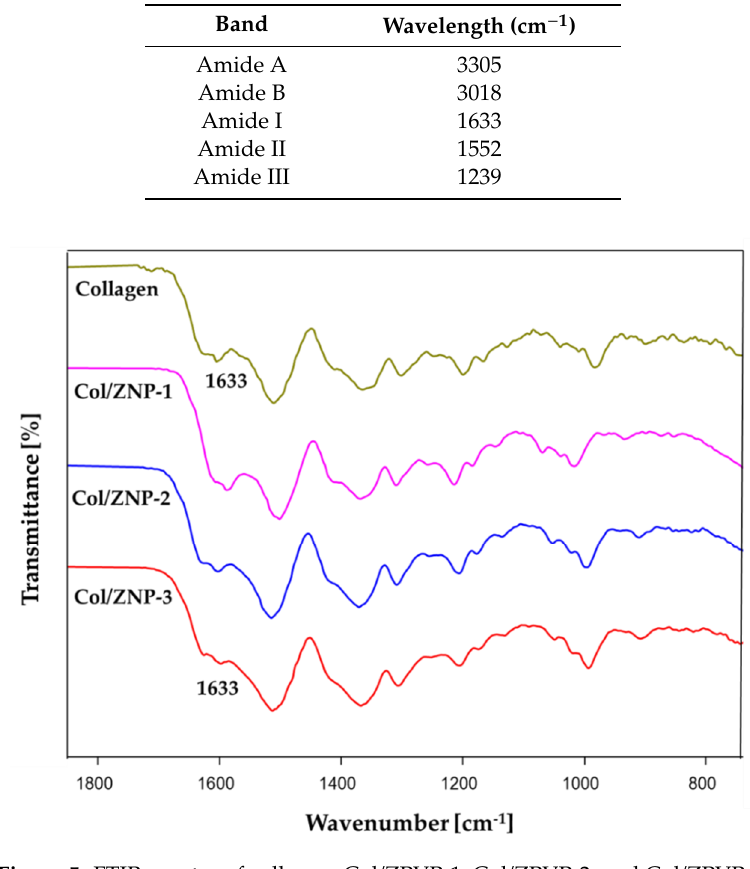
Figure 5. FTIR spectra of collagen, Col/ZPVP-1, Col/ZPVP-2, and Col/ZPVP-3.